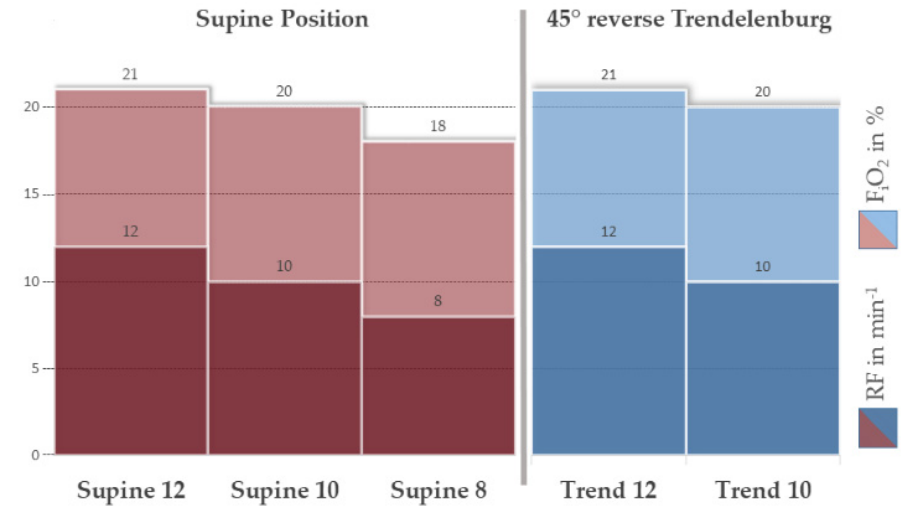
Figure 5. Experimental sequence plan. Fully anesthetized pigs were supported by intermittent mechanical ventilation with an initial respiratory rate > 12 min − 1 and F i O 2 of > 21%. The sequence plan shows incremental decreases of these values to model hypercapnic and hypoxic respiratory failure. After holding each plateau for 30 min, blood samples were taken. ECMO-support was adjusted to stabilize the vital parameters for each plateau. During the first three measurement points, the animal was lying in supine position, followed by a simple simulation of a mobilized patient by changing to 45 ◦ reverse Trendelenburg position (see Figure 6). These groups are referred to throughout the manuscript: Supine: animal was positioned flat on the back; Trend: 45 ◦ reverse